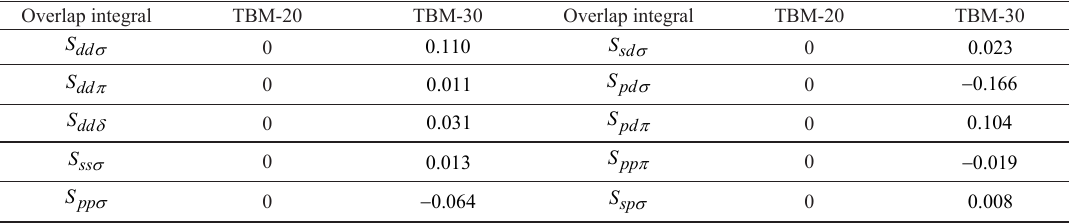
Table 3. As of Table 1 , but for the optimized overlap integrals. Overlap integral